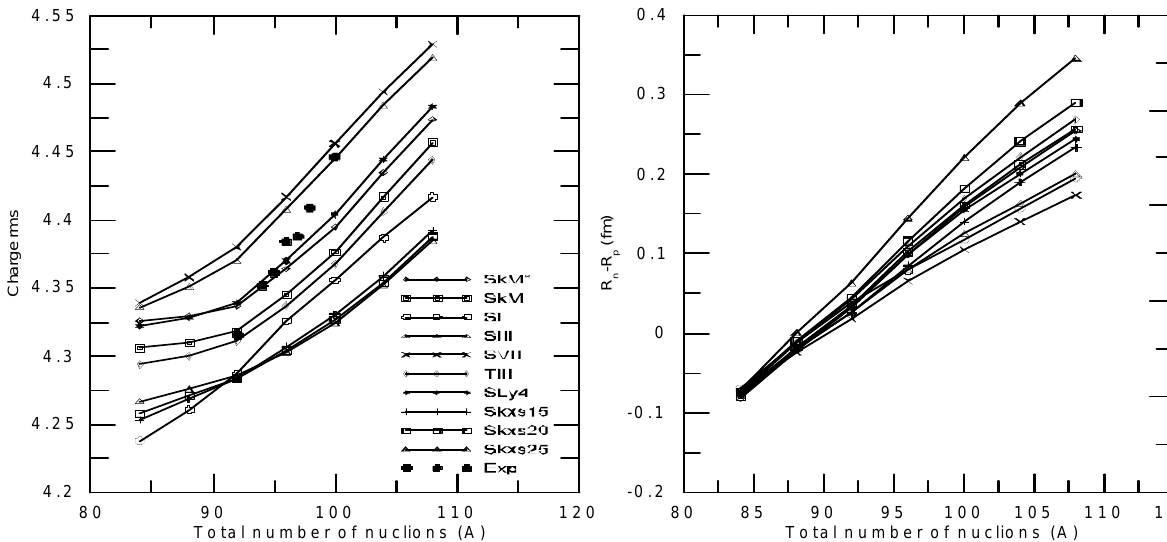
Fig.4: The calculated rms charge radii for 84-108 Mo isotopes using different Skyrme parameterizations.